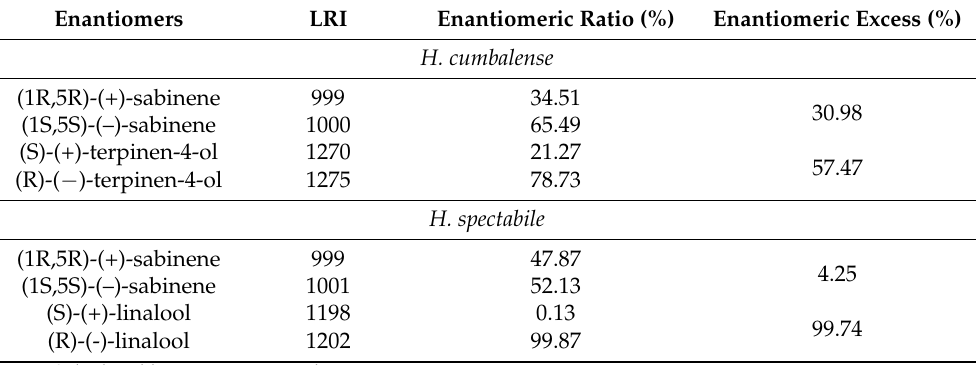
Table 3. Enantioselective analysis of the EOs with a 2,3-diethyl-6-tert-butyldimethylsilyl- β -cyclodextrin- based column.